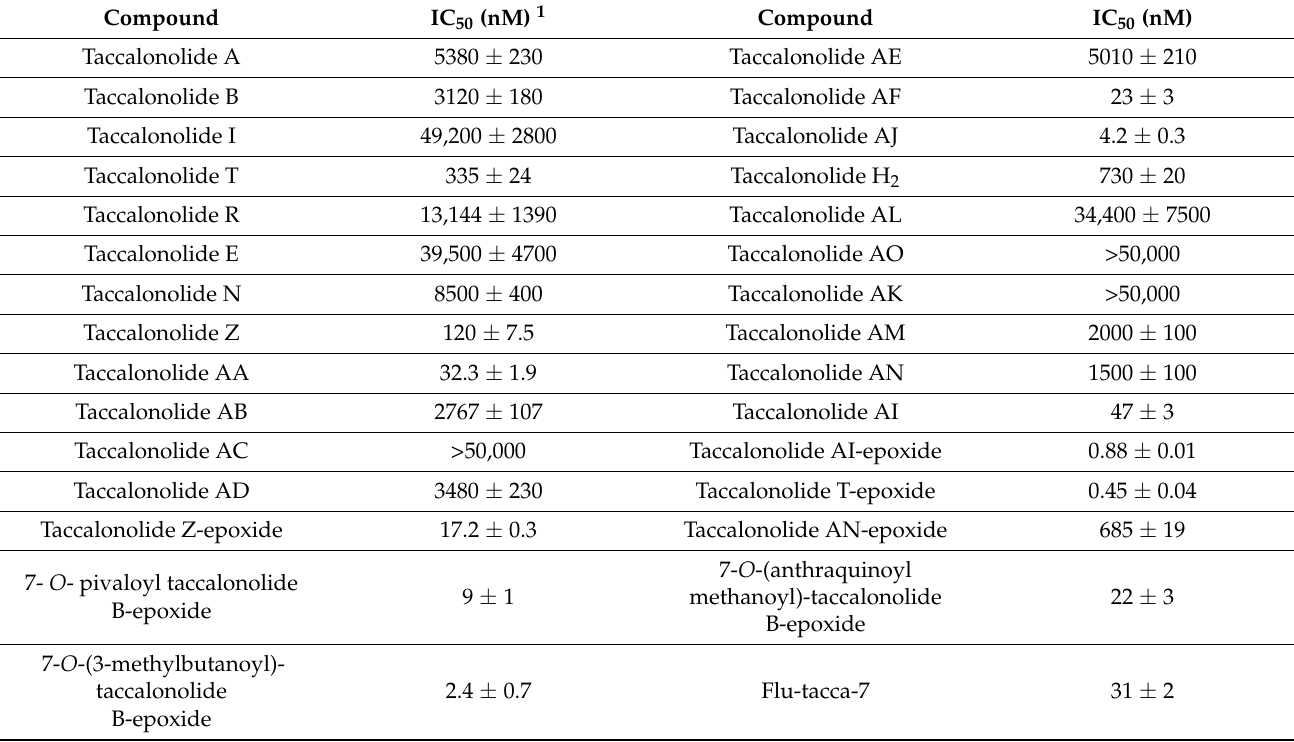
Table 4. Antiproliferative potencies of taccalonolides